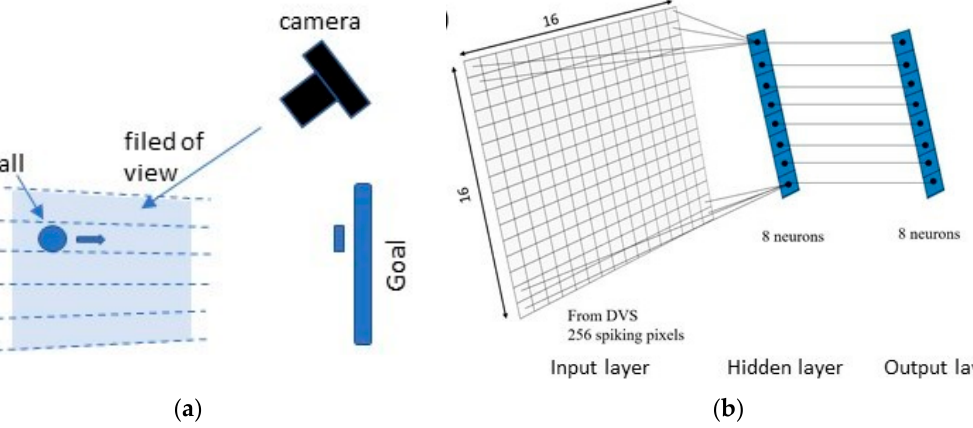
Figure 7. ( a ) Model: the neural network identifies in which of the possible N ‘lanes’ the ball is approaching the goal ( N = 8 in the demonstration). This model covers only a subset of all possible trajectories of the ball towards the goal, but it is sufficiently good approximation for the platform hardware demonstration purposes. The field of view of the DVS camera is approximately 35 cm × 50 cm (not a square because of perspective). ( b ) The spiking neuronal network (SNN) topology.